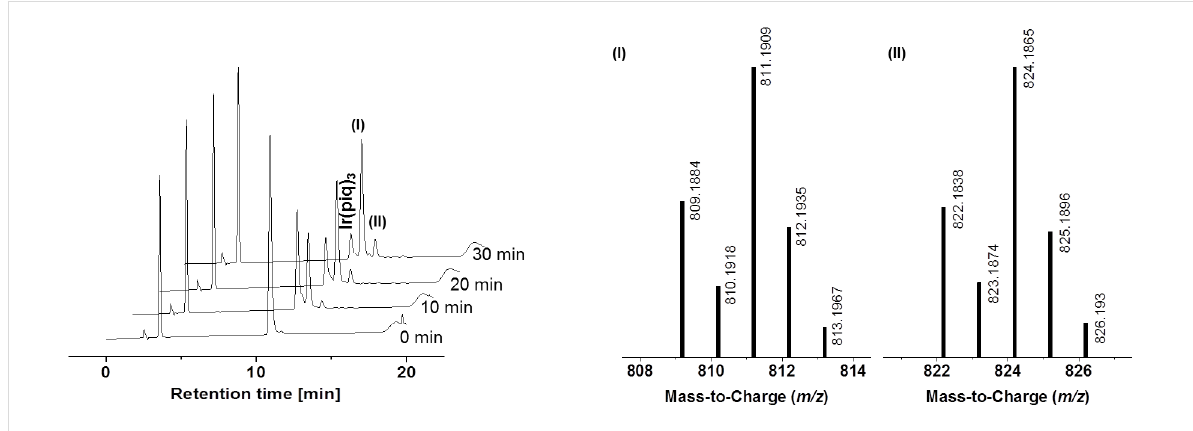
Figure 6: DAD chromatogram showing the formation of two main degradation products (left) and their assigned mass spectra (right).